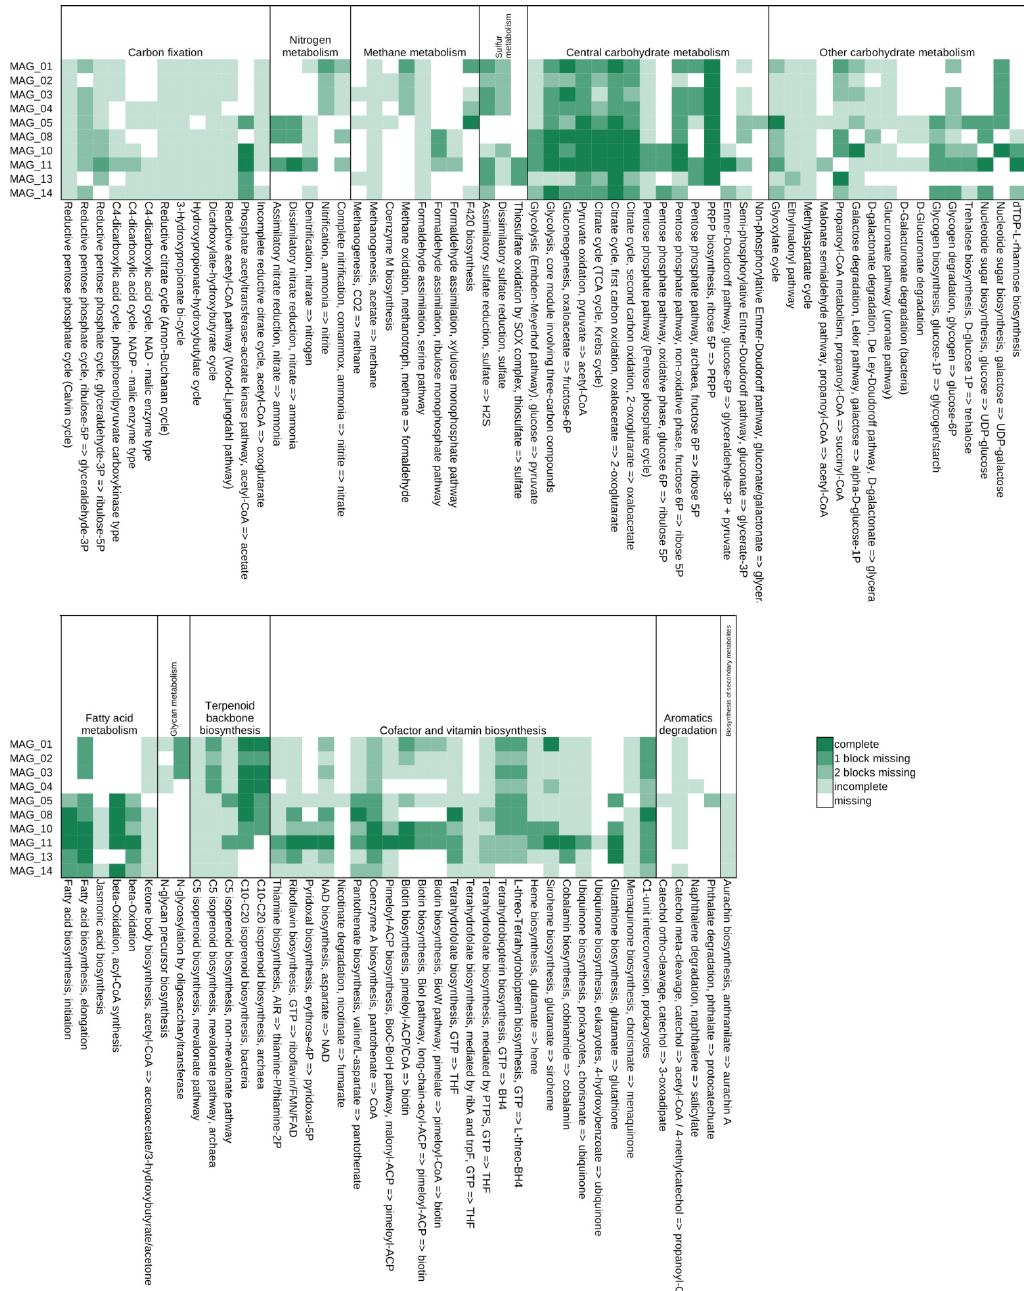
Figure 4. Functional potential of the ten high quality metagenomically assembled genomes (MAGs) as deciphered by means of KEGG (Kyoto Encyclopedia of Genes and Genomes) modules. Rows represent MAGs; KEGG modules are arranged in columns and grouped by superordinate category. Colors of the heatmap indicate the completeness level of identified KEGG